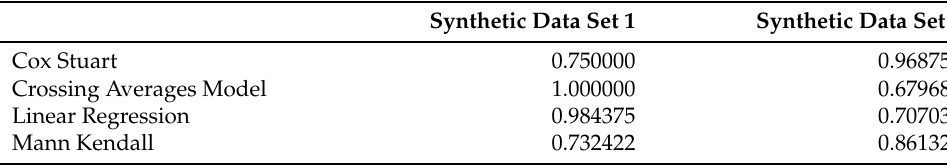
Table A2. Overview of the AUC values of the trend detection